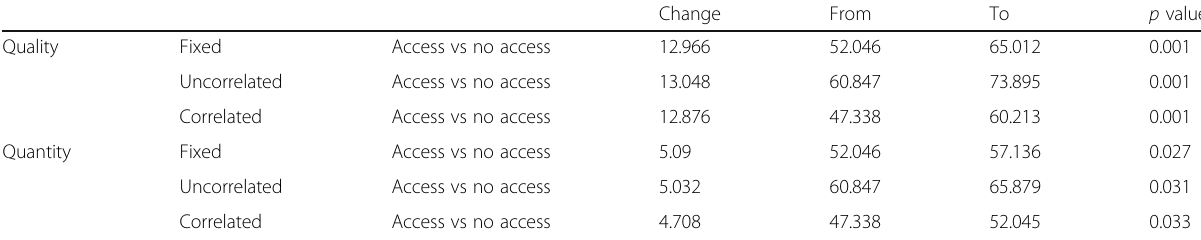
Table 11 Starting and ending probabilities of discrete changes for categorical/factor independent variables (water quality and quantity) across the three models Change From To p